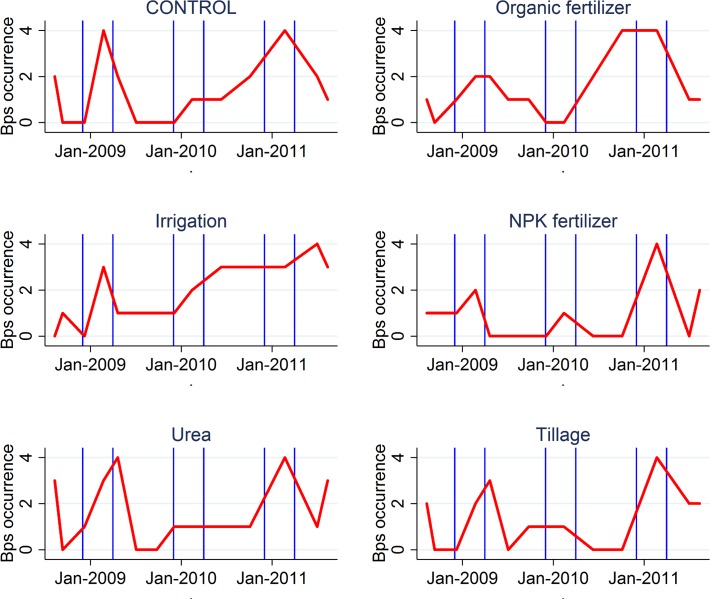
Longitudinal occurrence of B. pseudomallei (red line) on the experimental field site.The vertical blue lines indicate the start and end of the wet seasons. The y axis depicts the B. pseudomallei occurrence at total four holes per duplicate quadrants. The first measure was taken before treatments were applied.